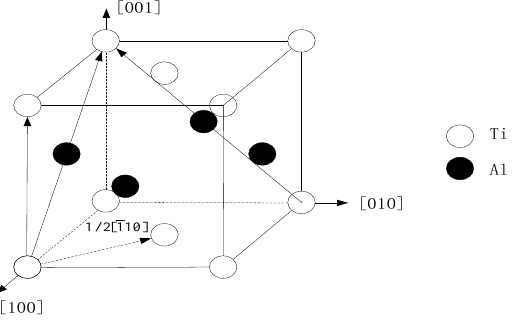
Figure 1. The crystal structure of γ -TiAl alloy.